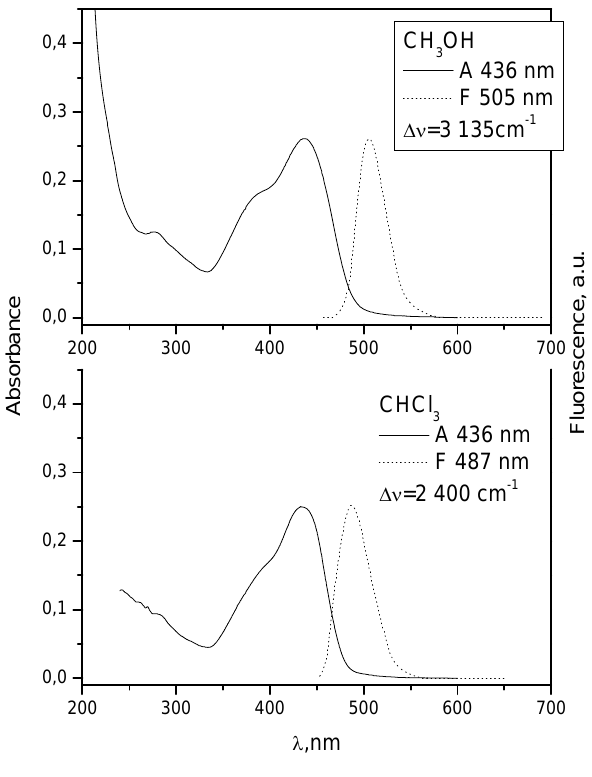
Figure 8. Absorption and fluorescence spectra of 2 in chloroform and methanol at 10 − 5 mol dm − 3 .